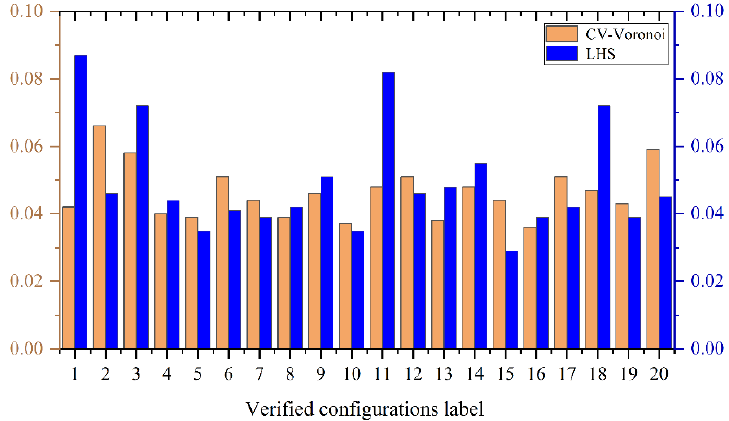
Figure 8. Accuracy of the verified configurations computed by updated global POD ROM: ( a ) RMSE values; and ( b ) energy–frequency curves of the No.2 verified configuration.